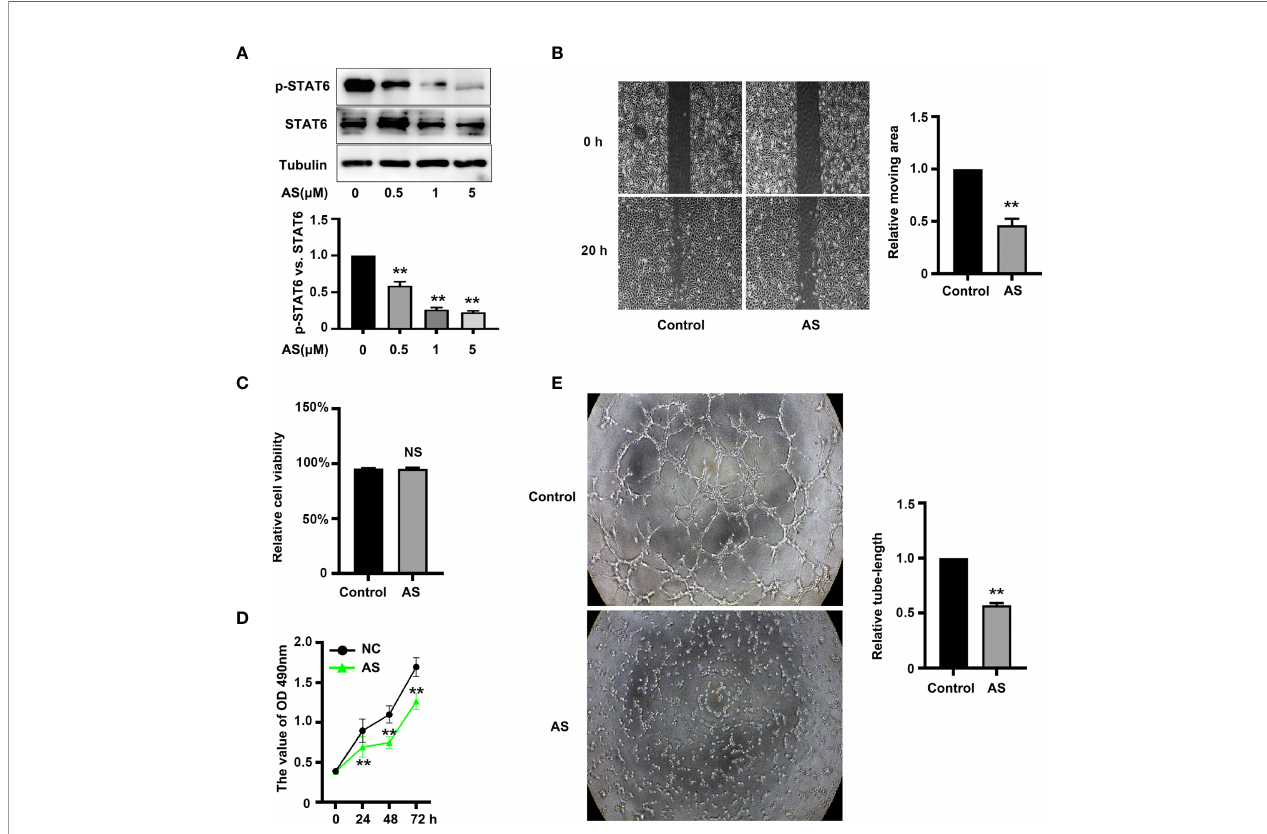
FIGURE 1 | AS treatment reduces STAT6 activity and inhibits HUVEC migration, proliferation, and tube-formation. (A) Phosphorylation of STAT6 was detected by western blotting in HUVECs treated with 0.5, 1, or 5 m M AS for 24 h, n=3, * P <0.05 vs. control. (B) The typical images and the relative moving area of HUVECs treated with AS (1 m M) for 20 h, n=5, ** P <0.01 vs. control. (C) The relative cell viability of HUVECs treated with AS (1 m M) for 24 (h.) NS denotes no signi fi cant difference, (D) The cell growth curve of HUVECs treated with AS (1 m M) for 0 h, 24 h, 48 h, and 72 h, n=5, ** P <0.01 vs. control. (E) The typical images of STAT6 affected HUVECs tube-formation. HUVECs were treated with AS (1 m M) for 24 h, n=5, **P<0.01 vs.